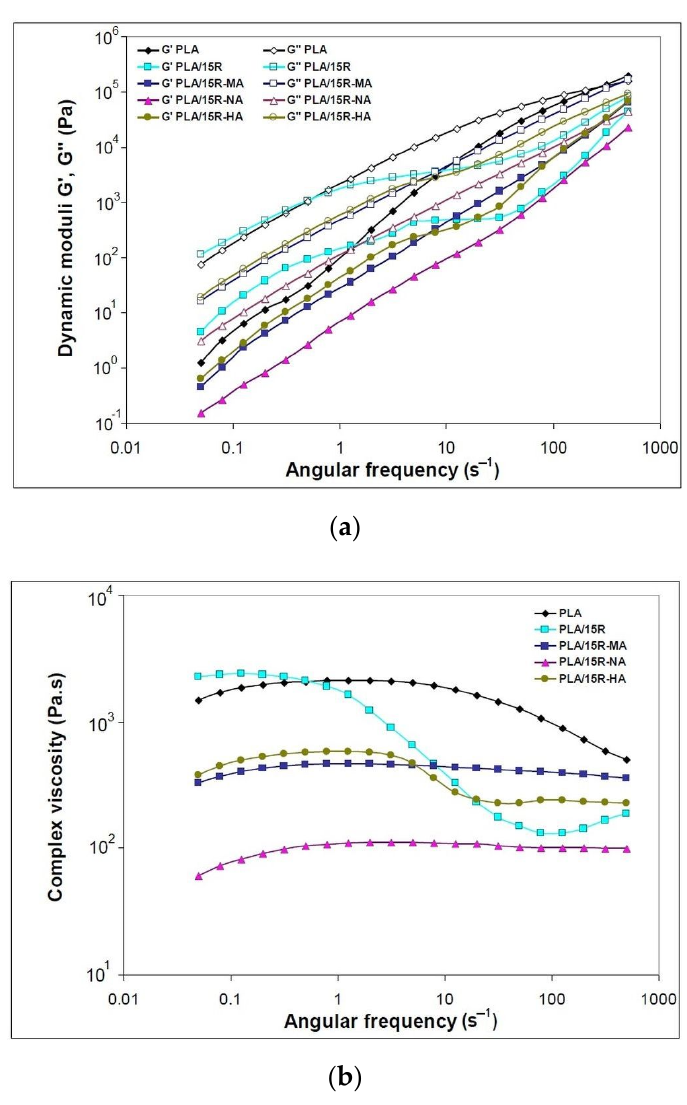
Figure 7. Variation of ( a ) dynamic moduli (storage moduli and loss moduli) and ( b ) complex viscosity function of angular frequency for neat PLA and blends plasticized with modified castor oil.